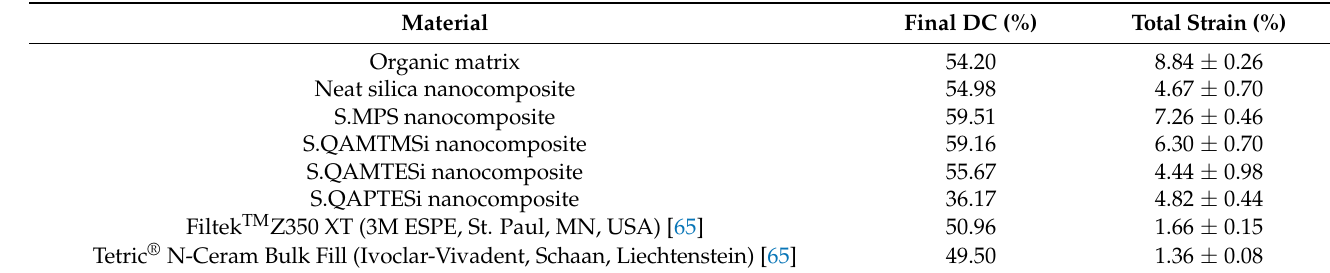
Table 3. Curing kinetics and polymerization shrinkage data calculated for Bis-GMA/TEGDMA matrix and dental nanocom- posite resins. Literature data for typical commercially available dental resins are also included